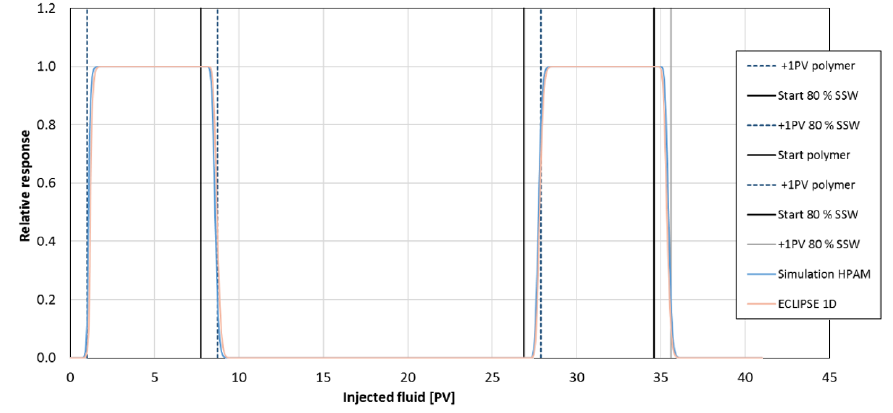
Figure 13. Comparison of polymer response between Schlumberger ECLIPSE and the developed simulator.